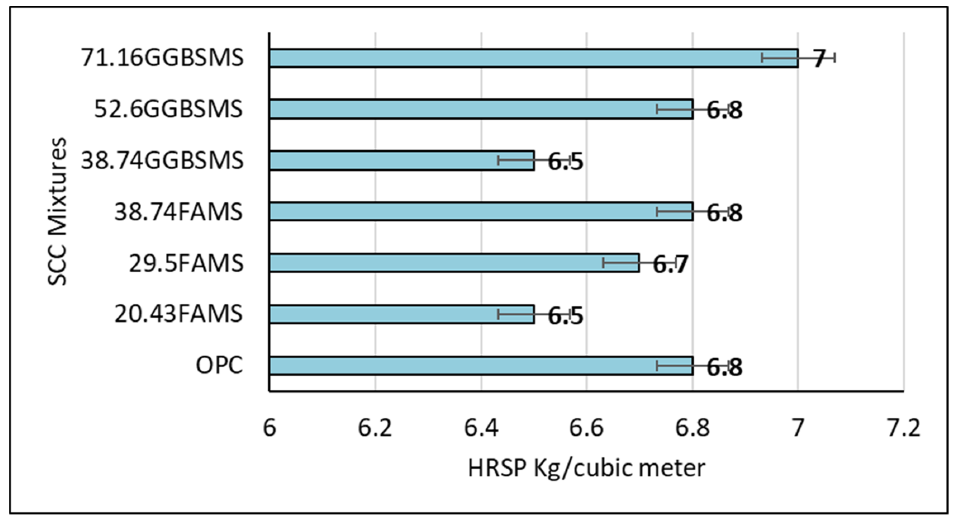
Figure 10. HRSP quantity used in